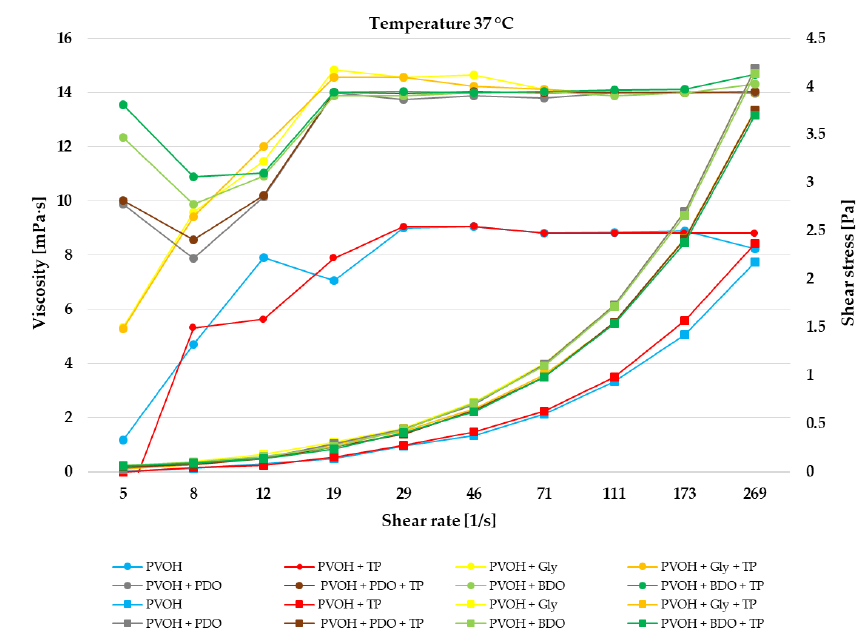
Figure 2. Shear viscosity and shear rate of biofilms at 37 °C temperature. The reported mean values with standard deviation (±) are available in Supplementary Material 1.